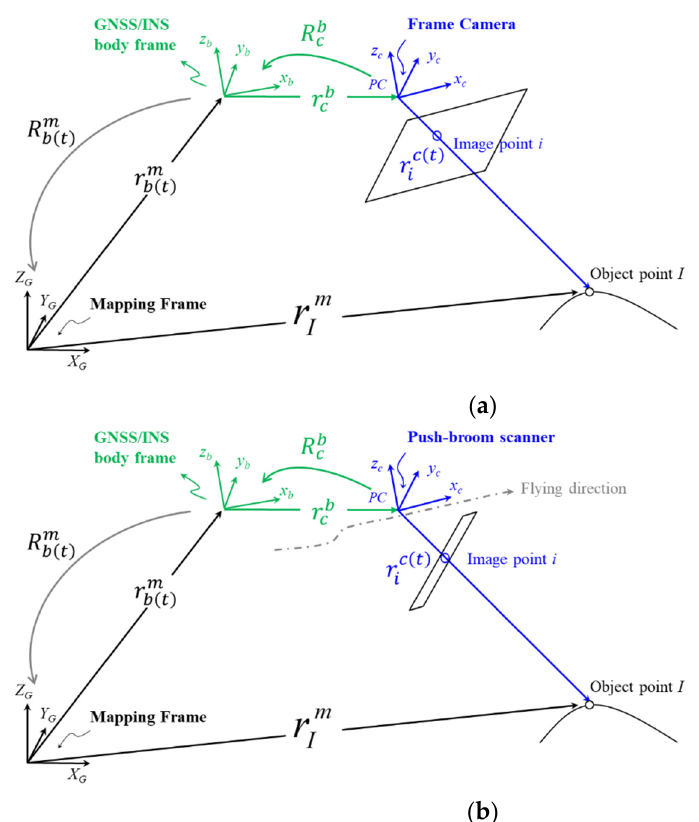
Figure 7. Schematic illustration of the indirect approach for orthophoto generation.